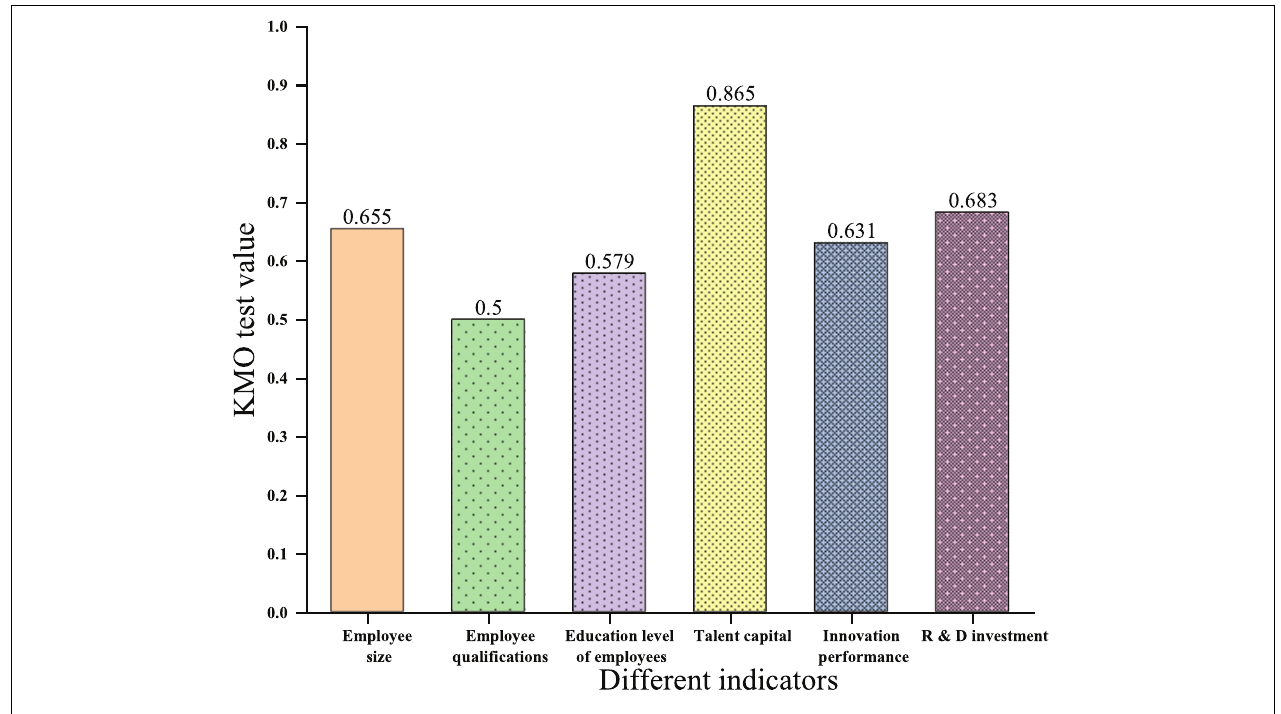
FIGURE 4 | Kaiser–Meyer–Olkin test value in first-level